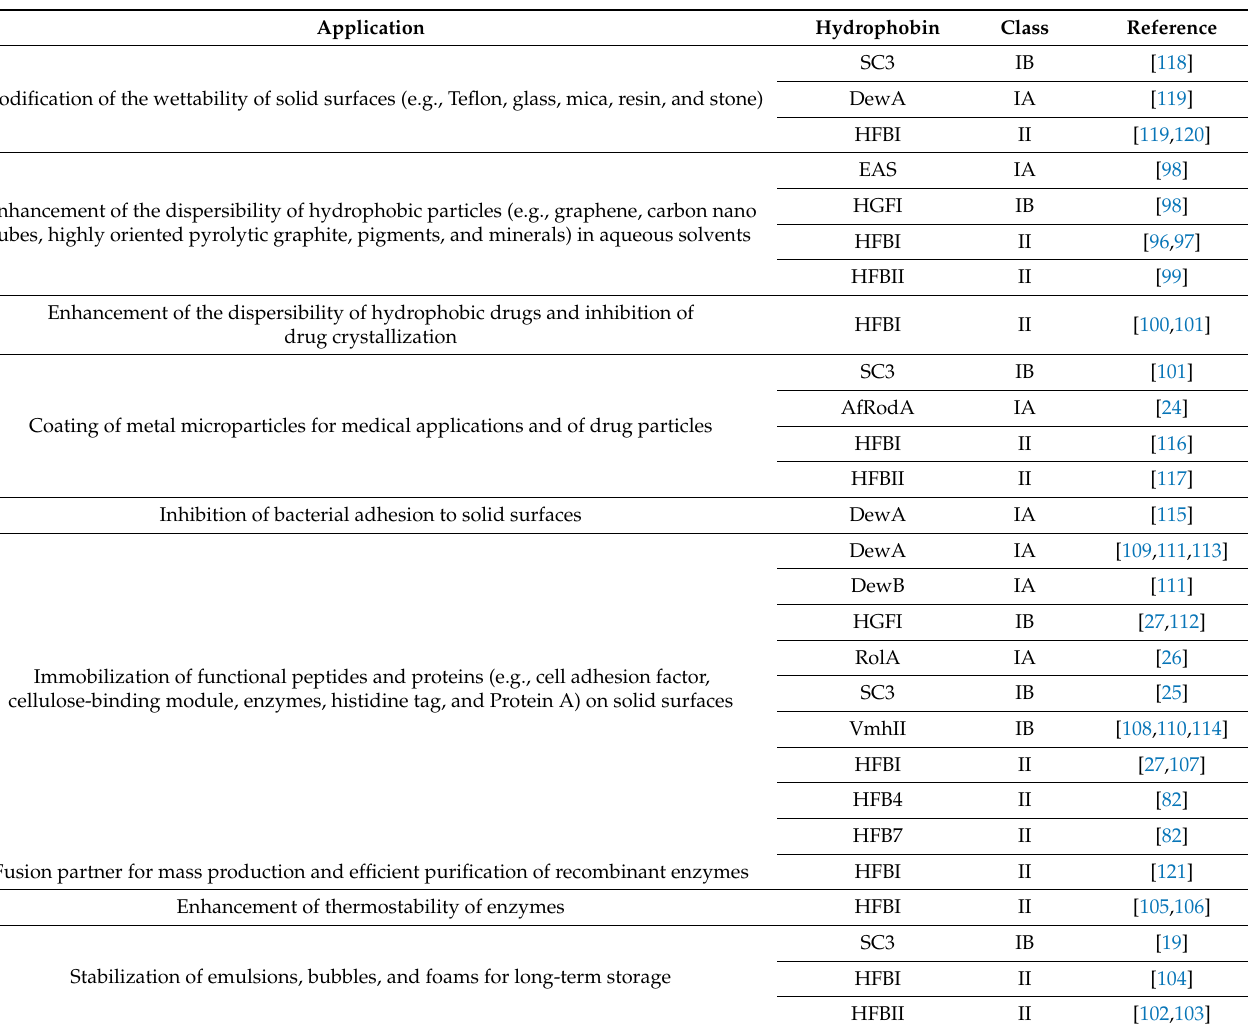
Table 1. Expected applications of